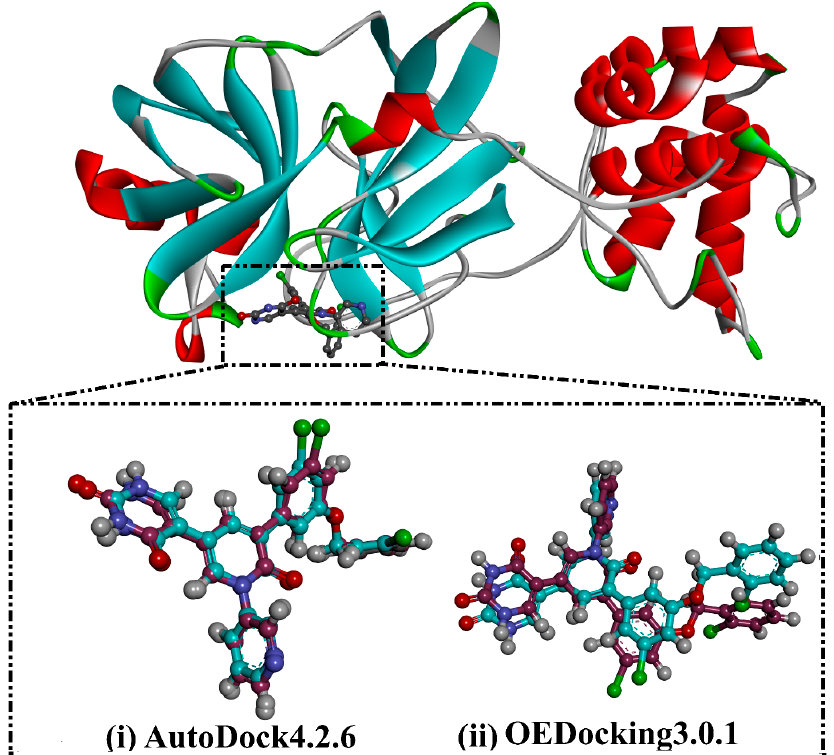
Figure 2. 3D molecular interaction of the experimental structure (in dark red) and the portended docking pose (in cyan) of XF7 in complex with the 3CL pro using ( i ) AutoDock and ( ii ) OEDocking software, respectively.